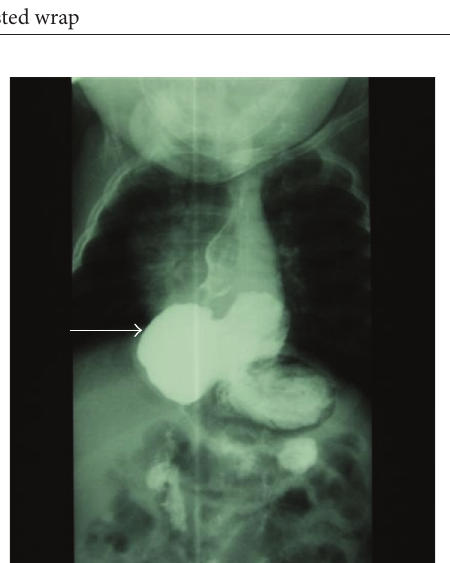
Figure 4: Upper gastrointestinal series. This imaging study reveals a slipped wrap with intrathoracic herniation